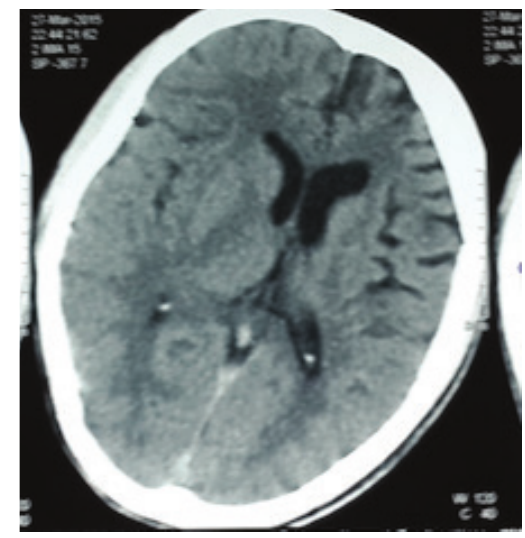
Figure 3: CT scan head showing prominent sulci